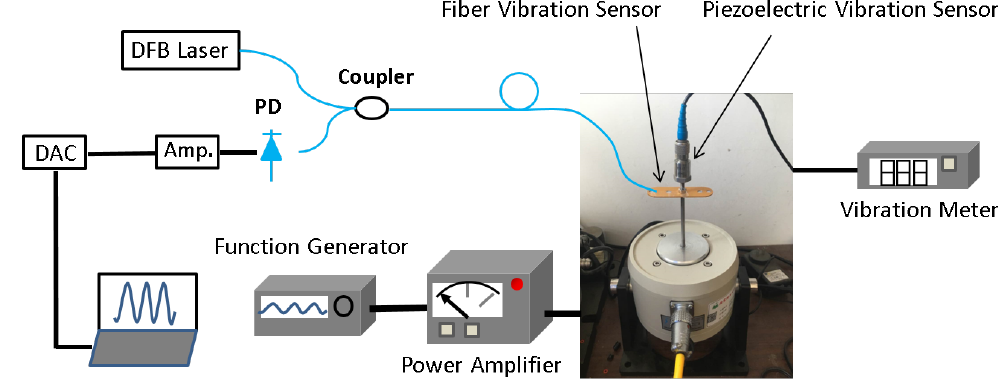
Figure 5: Experimental setup for vibration sensor